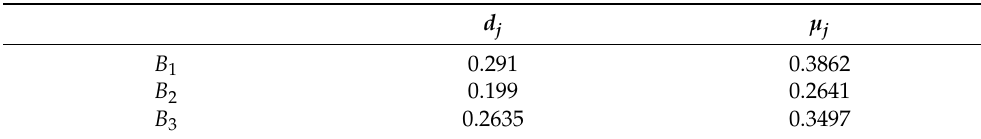
Table 9. Evaluation index weights based on entropy method.